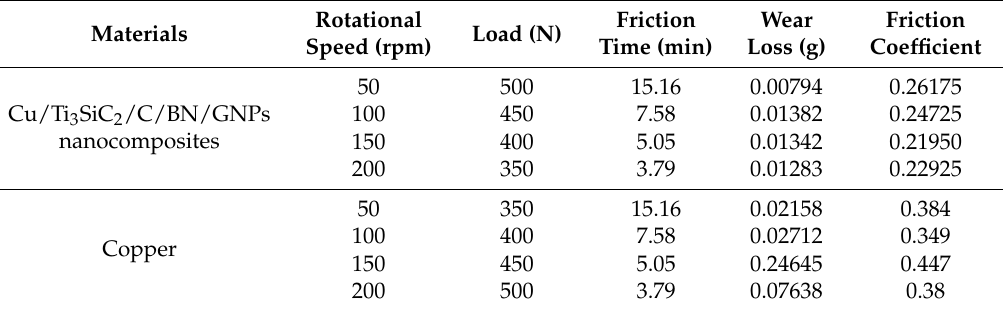
Table 2. Conditions and results of orthogonality analysis